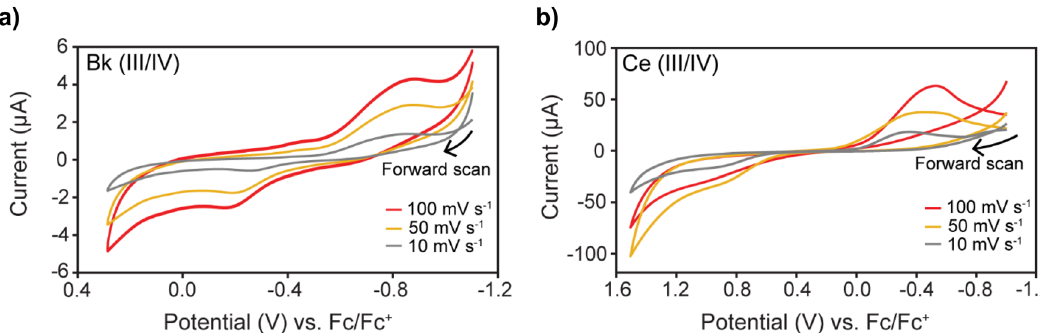
Fig. 2 Cyclic voltammograms of Ce III /Ce IV and Bk III /Bk IV terpyridine derivatives in THF and electrochemical data. Potential scan rates of 10 (gray), 50 (yellow), and 100 (red) mV s − 1 were used. a Voltammograms showing the oxidation (III/IV) and reduction (IV/III) of the Bk/Terpy* complex, in 0.1 M BArF (supporting electrolyte). b Voltammograms showing the oxidation (III/IV) and reduction (IV/III) of the Ce/Terpy complex, in 0.1 M TBA PF 6 (supporting electrolyte). All data have been corrected to zero volts vs. an internal Fc/Fc + reference. Table 1 Electrochemical